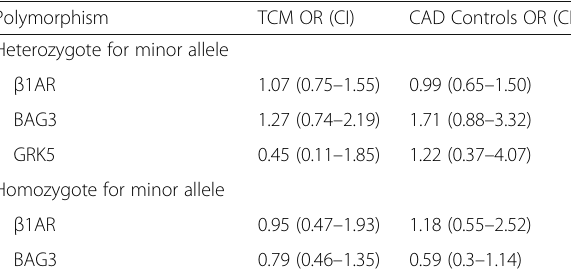
Table 3 OR and CI for TCM patients and controls with CAD being heterozygote and homozygote for minor allele in the ADRB1 (G), GRK5 (T) and BAG3 (C) gene